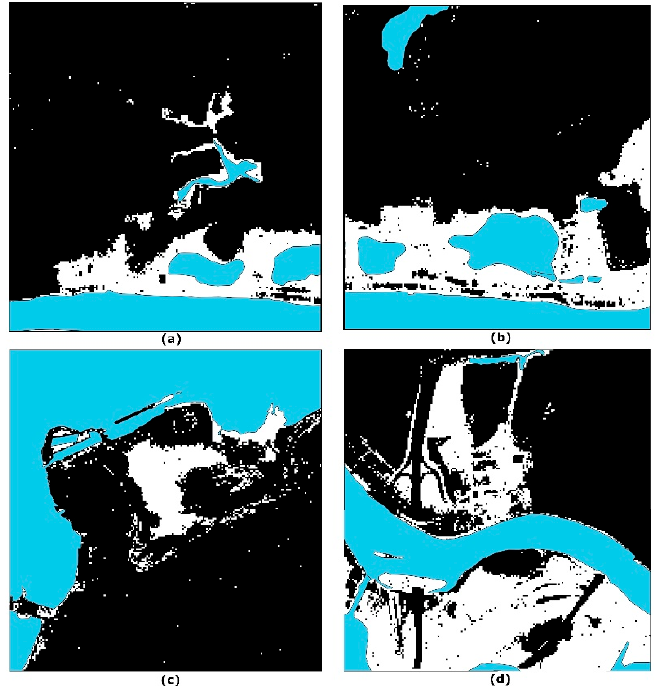
Figure 9. Generated flood maps over ( a ) Area1, ( b ) Area2, ( c ) Area3, and ( d ) Area4. Blue areas indicate water bodies and the river, while black and white areas show non-flooded and flooded areas, respectively.